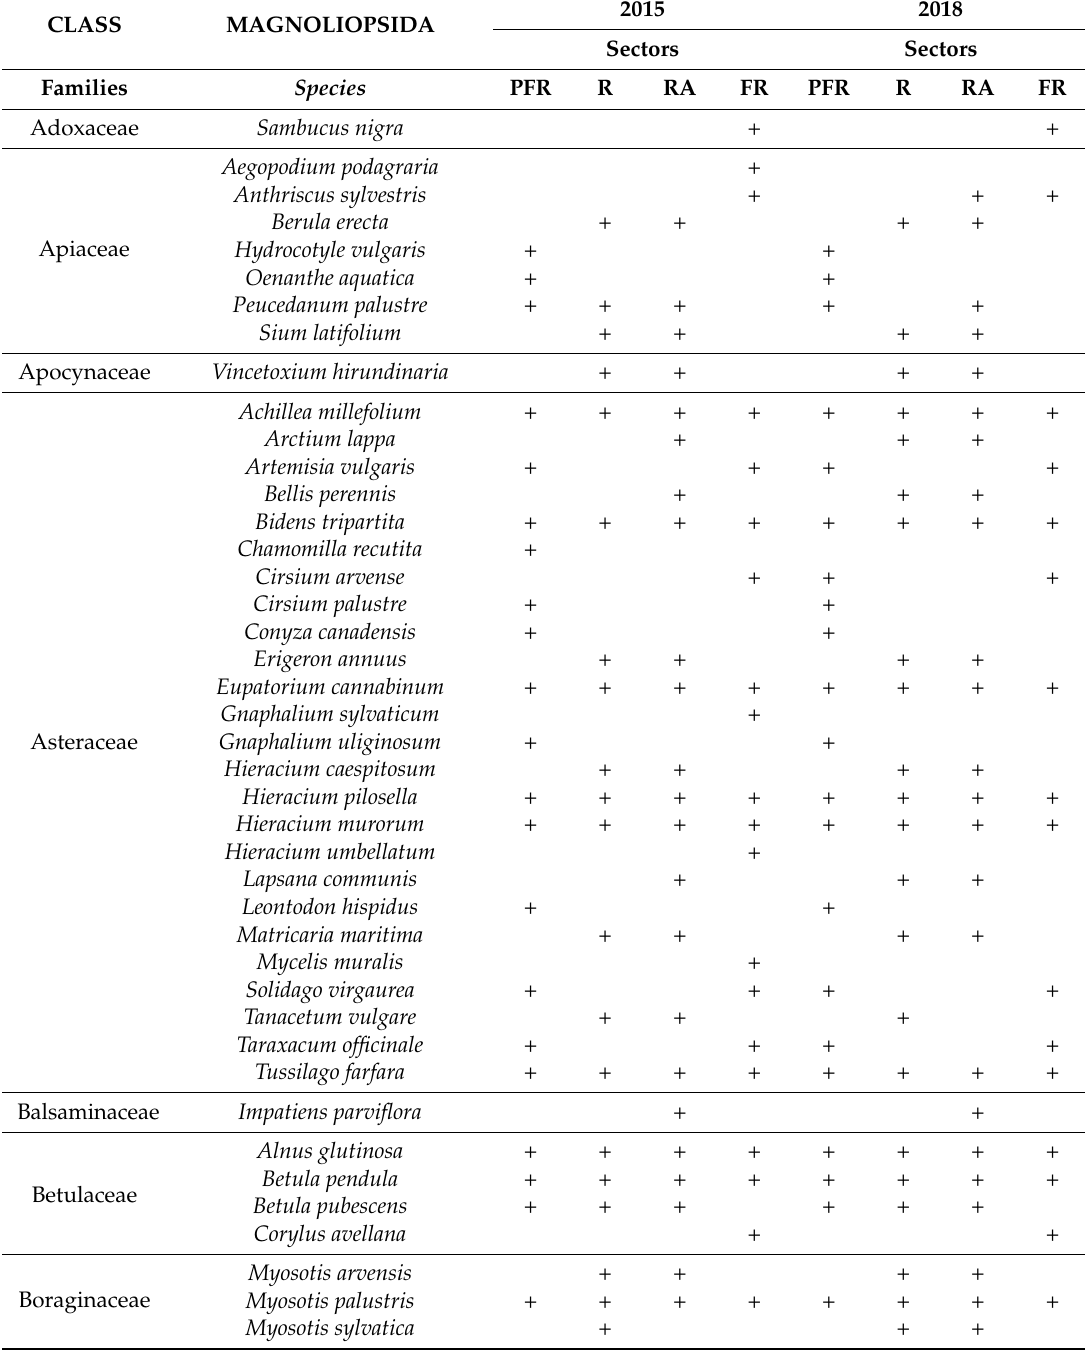
Table 3. The species composition of the shore vegetation of Lake Piaseczno in 2015 and 2018 (PFR, R, RA, and FR: catchment sectors; +: species present in the